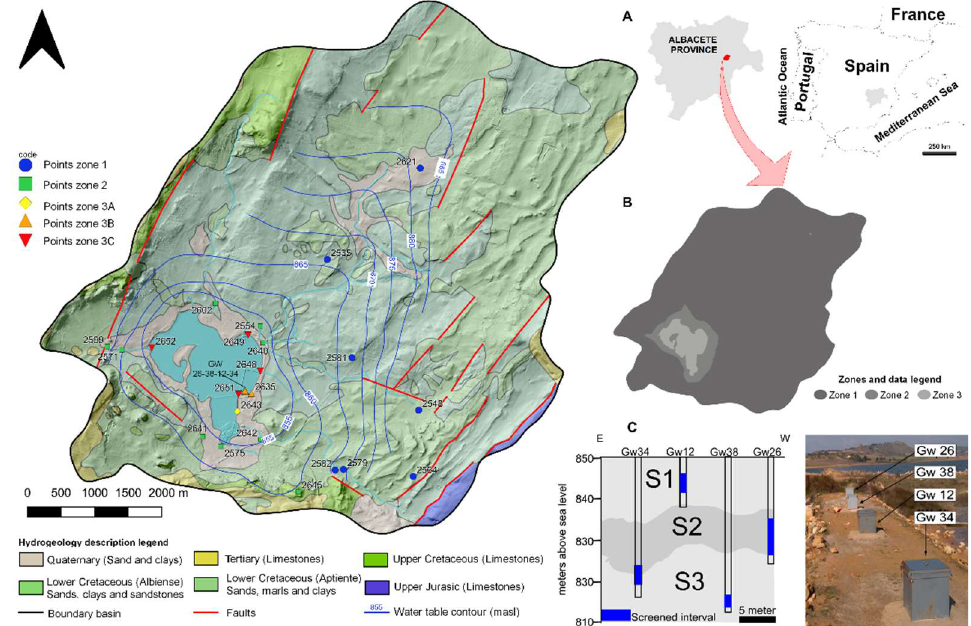
Figure 1. Hydrogeological map modified from [21]. Groundwater-level contour map over hillshade. Sample points for 2008–2010 and 2013–2015 campaigns are also given. The sketches summarise processes around the discharge flow lake type and show regions where evaporated water from the lakes mixes with the through-flowing groundwater. ( A ) Location of the study area. ( B ) Hydrochemical zonation. ( C ) Piezometers that monitor different depths of the aquifer under the lake, and photograph of the location of the piezometers. (S1) upper sandy sediments aquifer, (S2) mid argillaceous sediments aquitard, (S3) down sandy sediments aquifer.